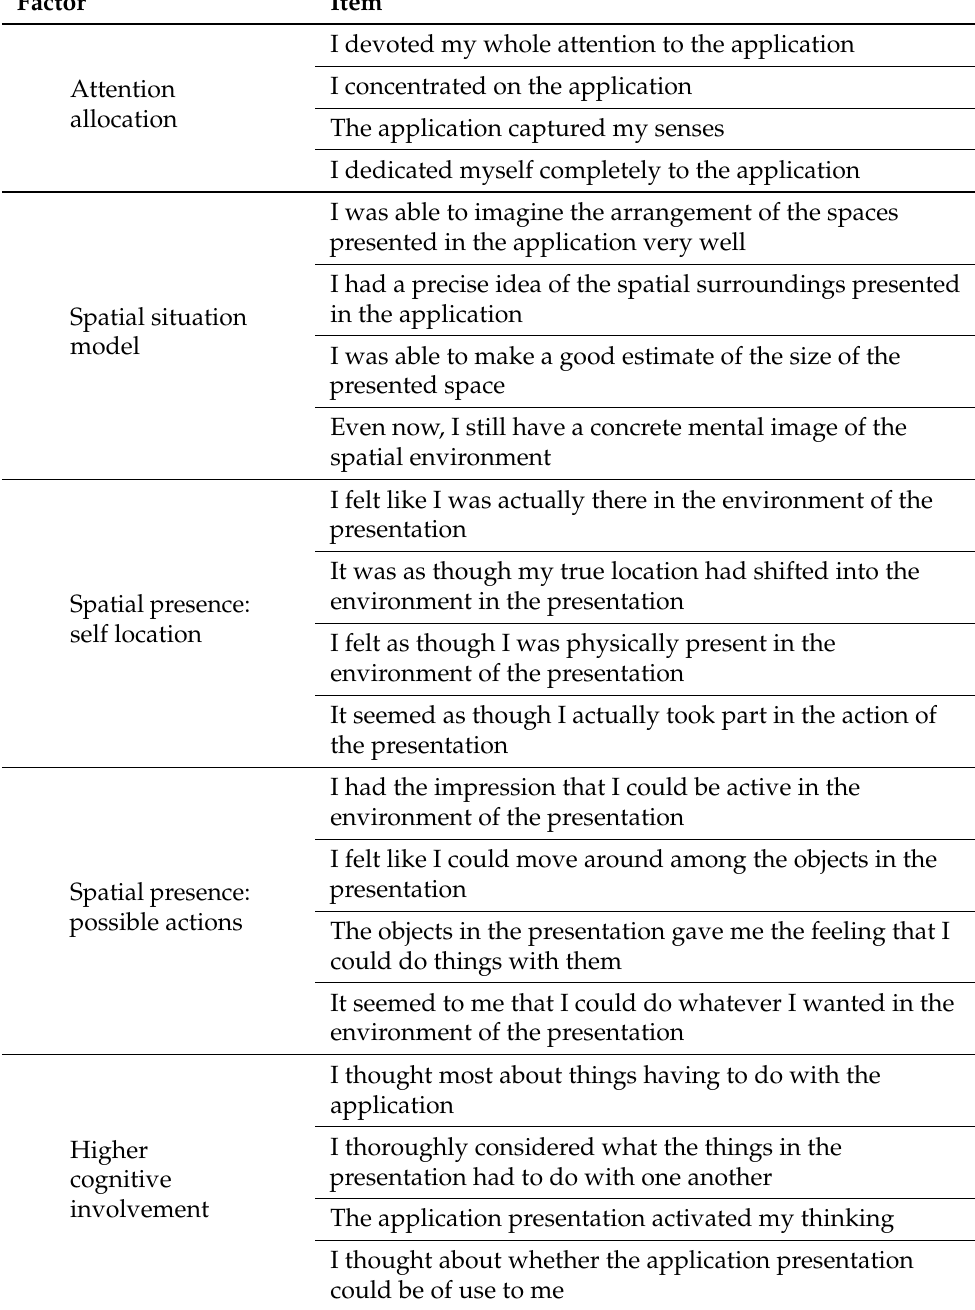
Table 1. Short version of the MEC Spatial Presence